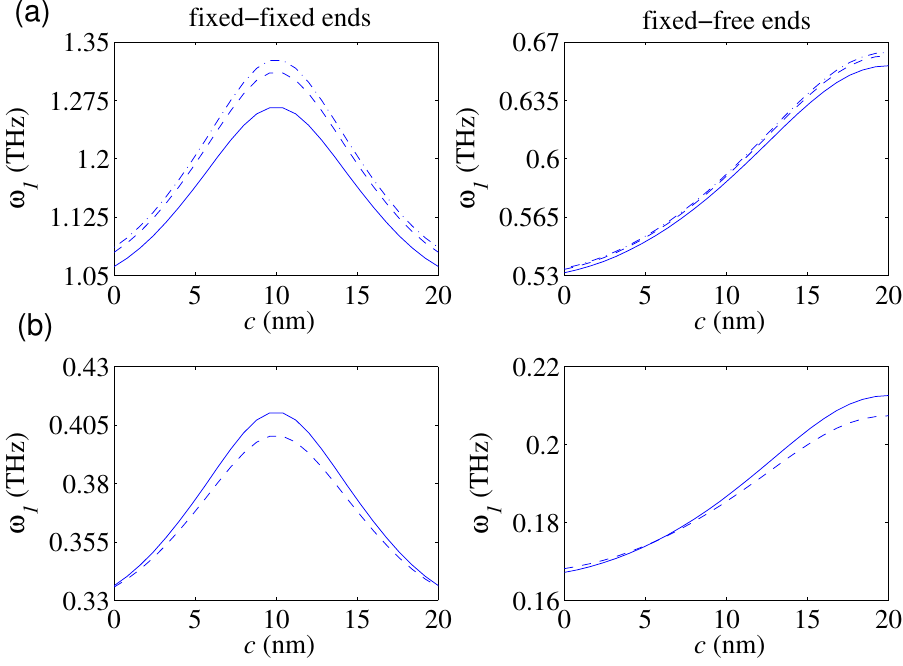
Figure 3. The fundamental frequency in terms of the single defect’s location for: ( a ) three values of e 0 a ; (( − . − ) e 0 a = 0, ( −− ) e 0 a = 1 nm, (—) e 0 a = 2 nm; ¯ k 1 = 4, χ 2 models; ( l b = 20 nm, D 0 = 0.5 nm, e 0 a = 2 nm, ¯ k 1 = 4, N =1, ¯ H y = ¯ H z = 0.1; ( −− ) NET, (—)